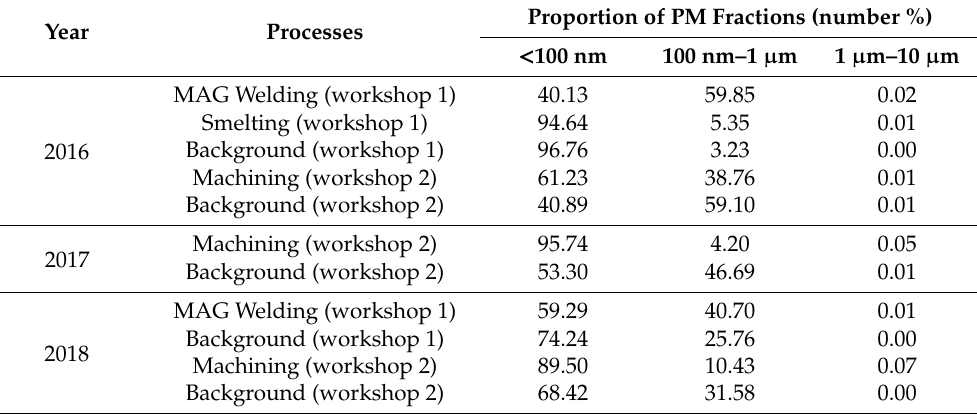
Table 5. Number proportions of particulate matter (PM) fractions measured by online monitoring (SMPS and APS) during the shift related to individual working processes.